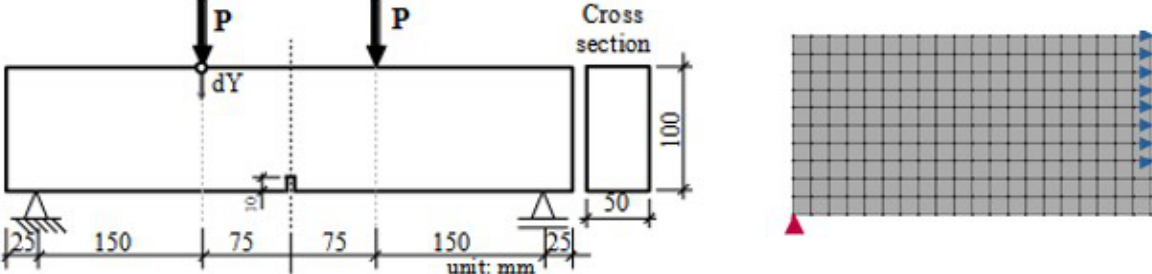
Figure 12. Three-point bending test: geometry and mesh.